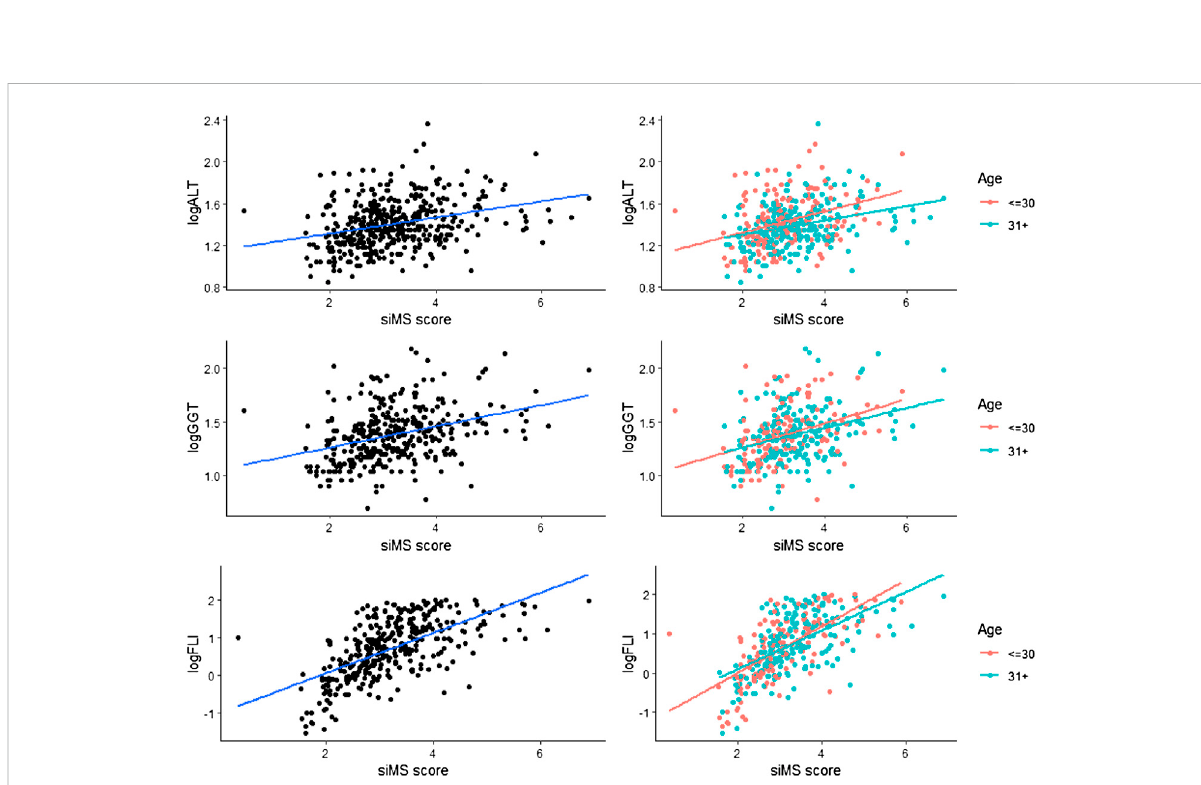
FIGURE 2 siMS score correlations with NAFLD parameters: log ALT, log GGT and log